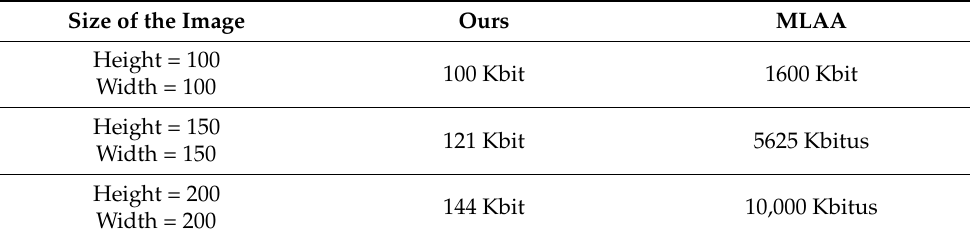
Table 2. Memory size used to store the area texture of the two